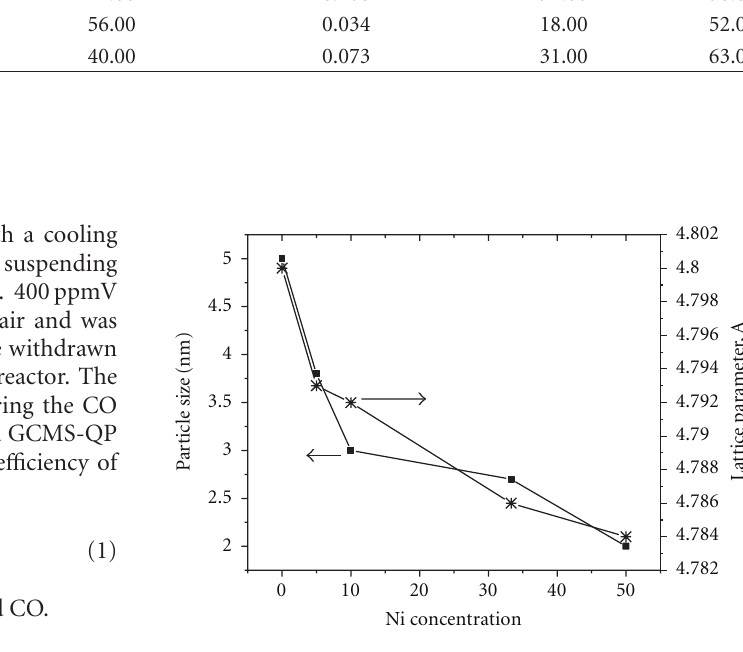
Figure 3: Variation of particle size and lattice parameter with nickel